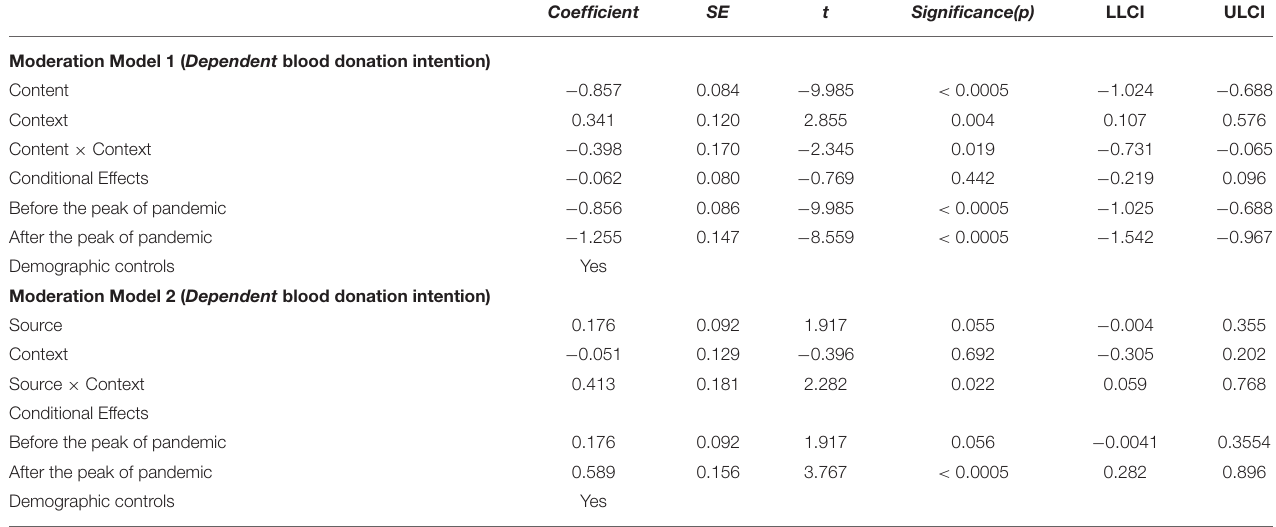
TABLE 5 | Moderation